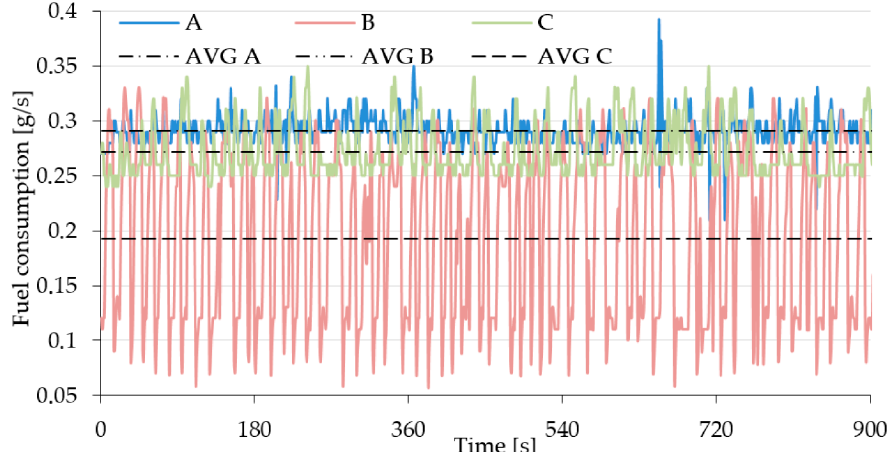
Figure 7. Fuel consumption as a time function during the chipping process: A: Carburettor fuel supply system; B: Injector fuel supply system; C: Injector fuel supply system equipped with an adaptive drive control system.